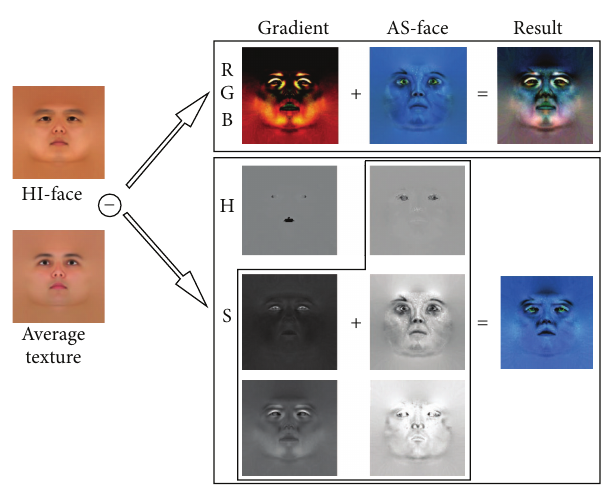
Figure 7: Comparison of the artistic texture synthesis process if different color spaces (RGB or HSV) are used. To emphasize the difference, the gradients are scaling up by 5. Blending in the RGB colorspaceleadstoafacetexturewithhuman-skin-base-color,while blending in the HSV color space (maintaining Hue) produces a face texture with artistic-style-base-color.